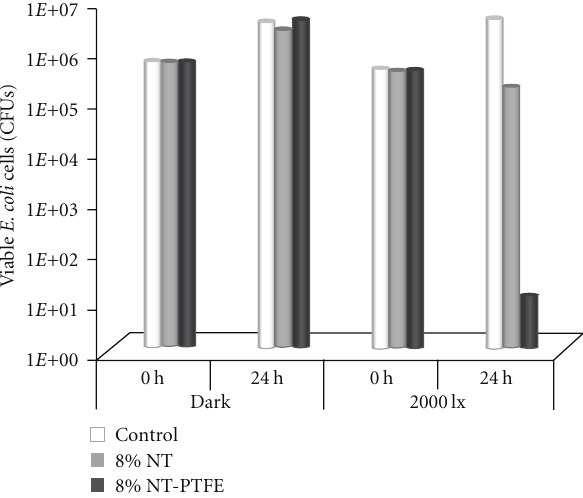
Figure 5: Antibacterial activity of PTFE hydrophobic composite films with N-doped TiO 2 (NT) on MRSA under 2000 lx of visible light illumination for 24 h. The PTFE hydrophobic without NT was used as control.